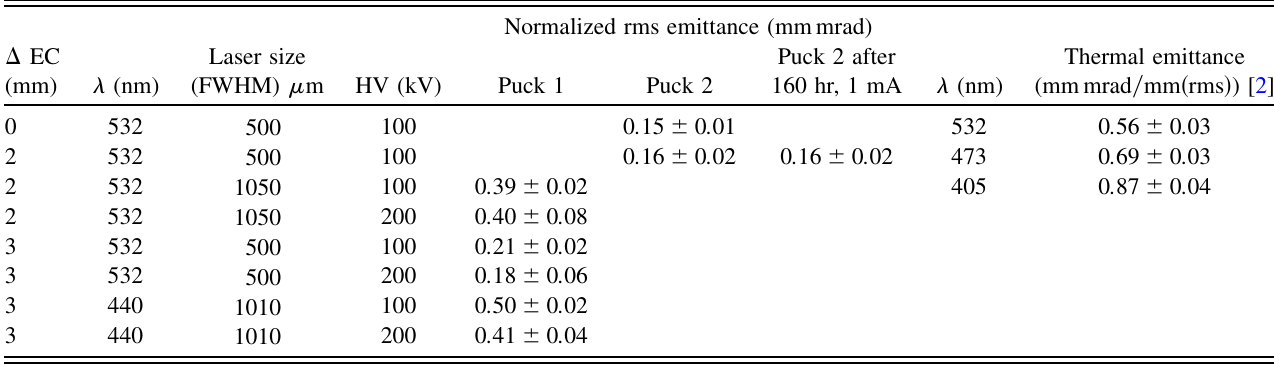
TABLE II. Geometric normalized rms emittance measurement summary. (cid:1) EC is the laser spot distance from the electrostatic center. For comparison we have also listed published thermal emittance values